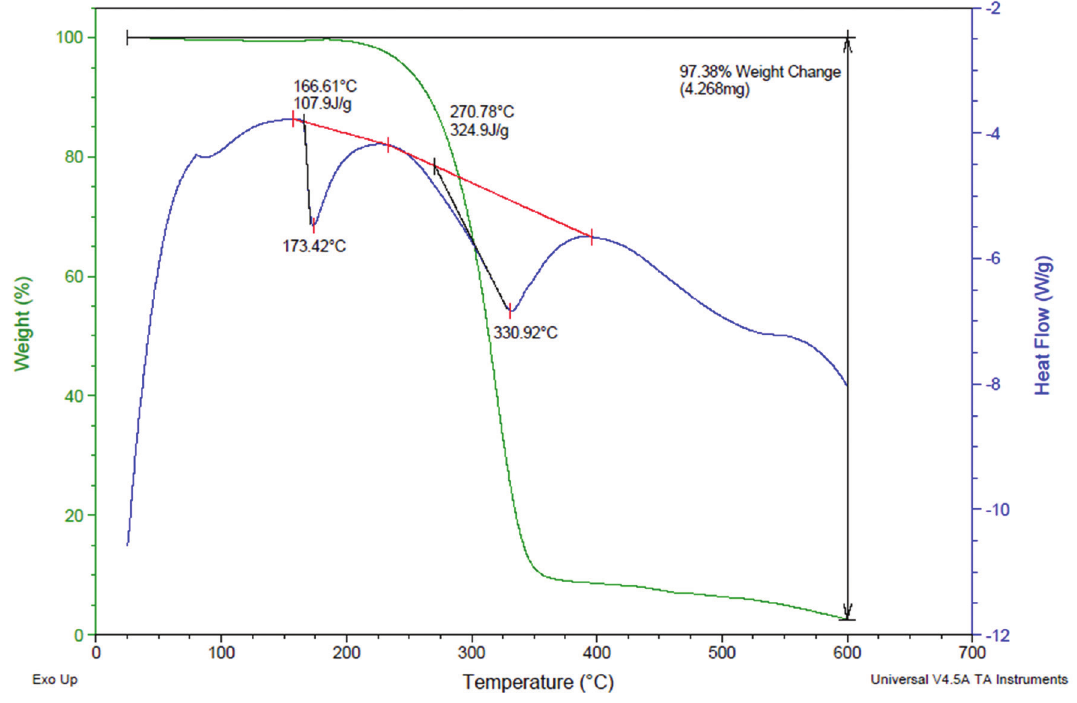
Figure 9: TG and DSC curves for 4-aminoacetanilide thermal decomposition (heating rate 10°C/min).